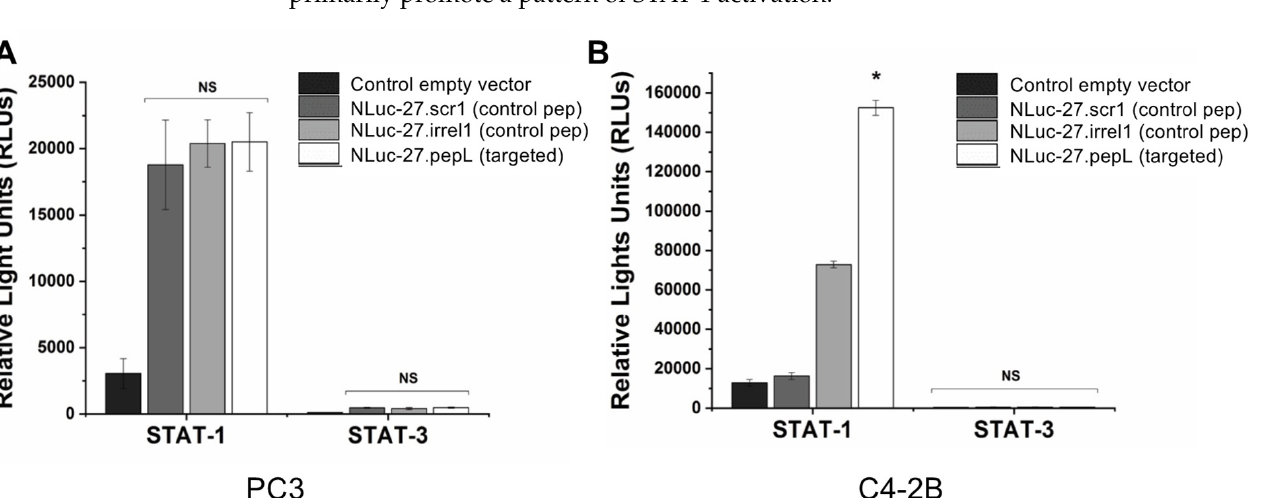
Figure 6. Validation of ligand-targeting efficacy in ‘sensor cells’ displaying differential expression of the target cytokine receptor, IL-6R α . Targeted Nluc-27pepL displayed a signal significantly higher than controls when incubated with HEK293. This ligand binding (homing) was enhanced in THP-1 cells which presented significantly more IL-6R α on the cell surface. Data are presented as mean ± SEM. Comparisons within cell types were performed using one-way ANOVA. A p -value < 0.05 indicates a significant difference (*). Comparisons between cell types were performed using unpaired t -test. A p -value < 0.05 indicates a significant difference (#).